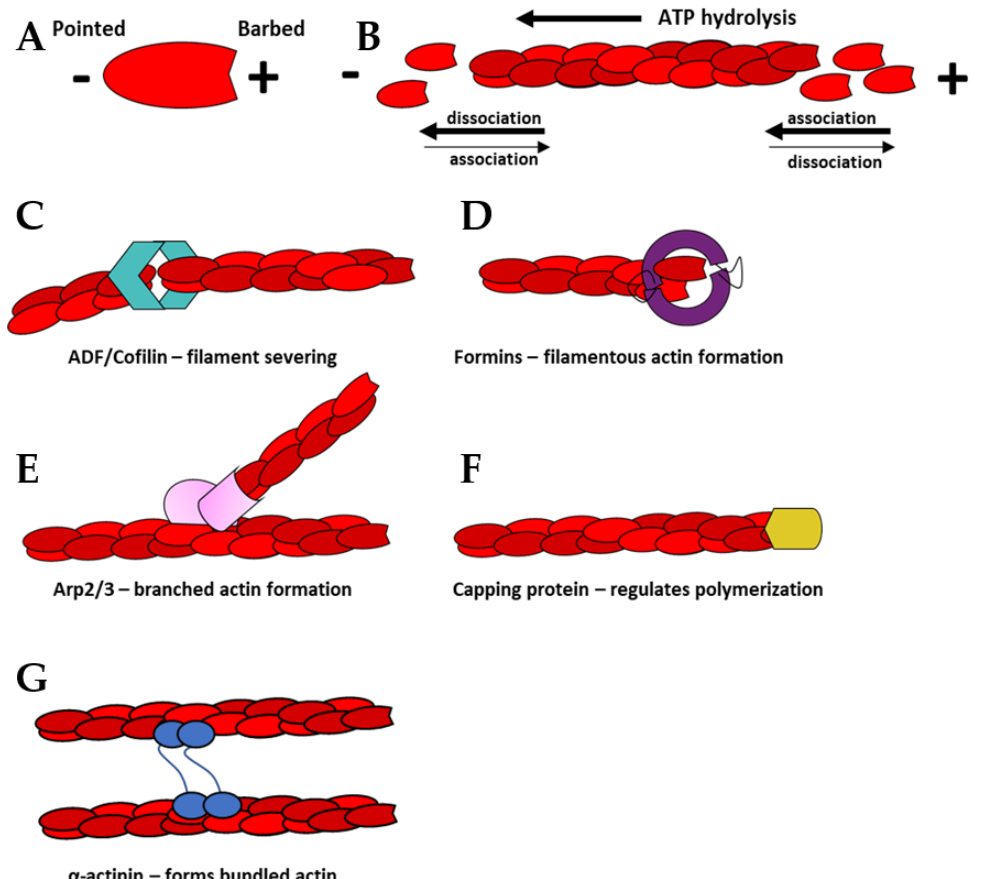
Figure 1. Illustration of actin polymerization and common actin binding or nucleation factors: ( A ) Actin monomers have a barbed (+) and pointed (-) end. ATP binds and magnesium ions bind to the barbed end. Filaments lengthen by binding barbed end to pointed end. ( B ) The monomer association rate is greater at the barbed end of the growing actin filament than the pointed end. This differences in association and dissociation rates at either end of the filament is what leads actin treadmilling. ( C ) ADF/Cofilin, (aqua), severs actin filaments preferentially towards the pointed end. Cofilin there- fore, significantly decreases the average lifetime of filaments. ( D ) Formins (purple), increase the rate of polymerization by directly associating with either actin seeds or established filaments and mon- omeric actin. ( E ) The seven-subunit nucleating complex Arp2/3 (pink), associates with established filaments and allows for the formation of branched networks. ( F ) Capping protein (CP) (yellow) regulates filament lifetimes by preventing filament growth at the barbed end. ( G ) Bundling proteins, such as α -actinin (blue), link parallel actin filaments together.